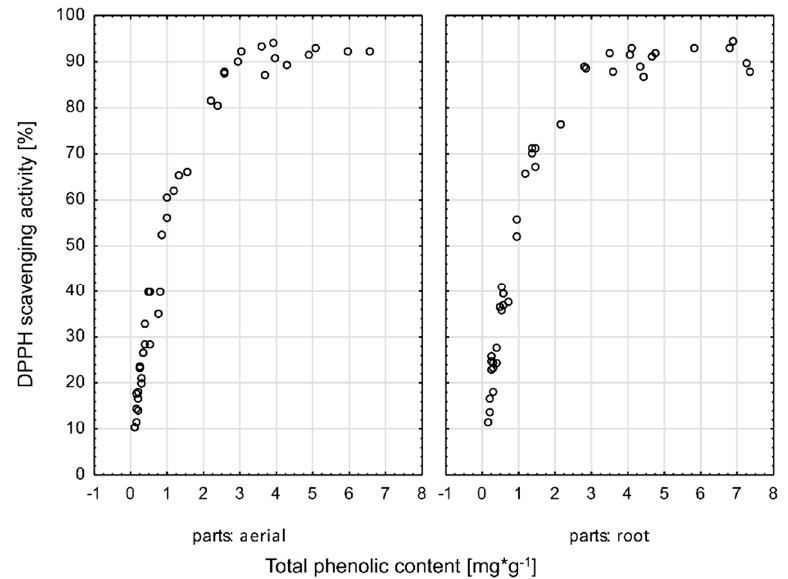
Figure 3. Correlation between the ability to scavenge DPPH and the content of polyphenolic com- pounds in the tested